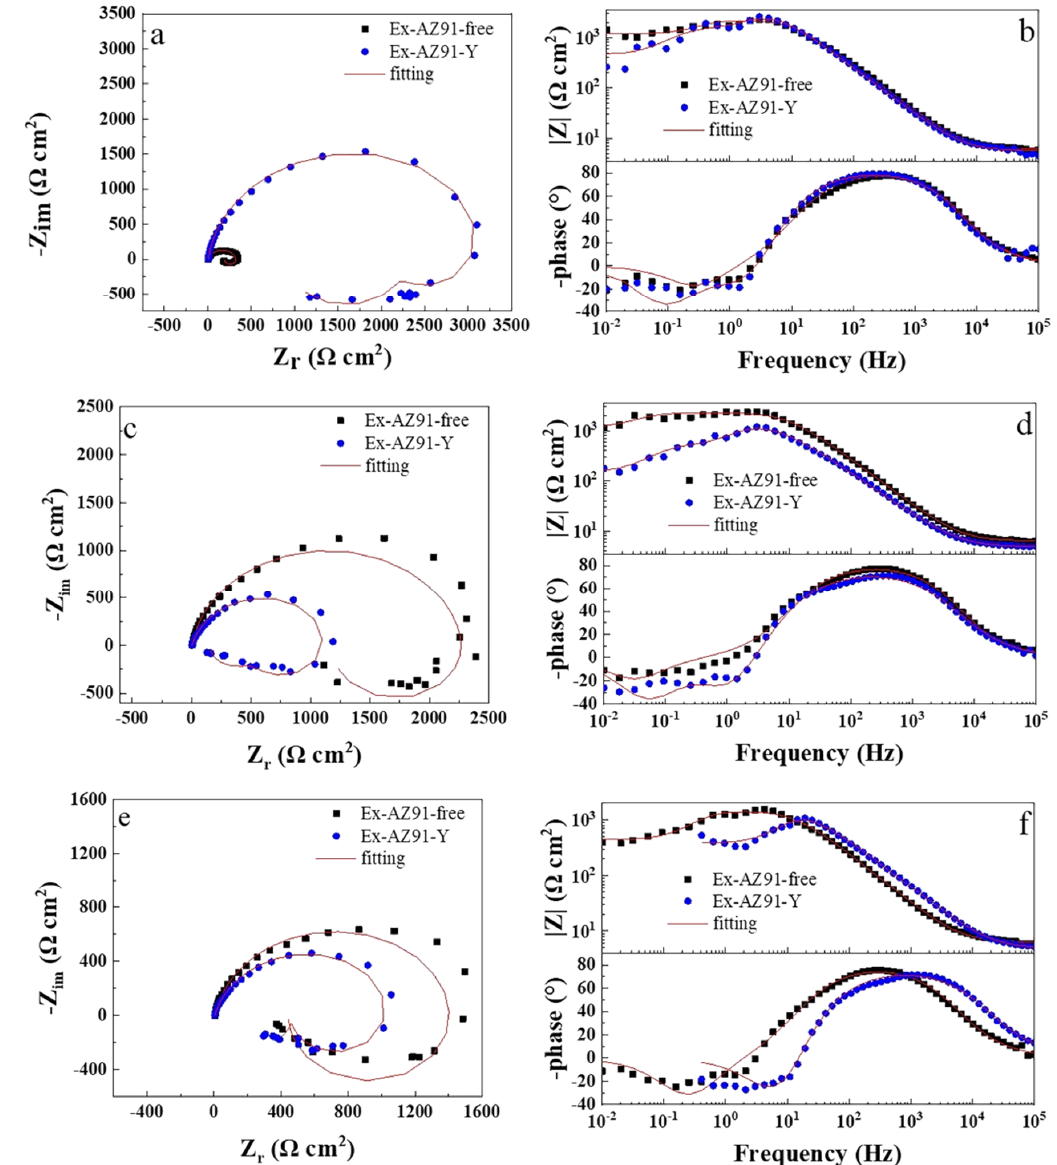
Figure 9. Nyquist and Bode plots of the longitudinal section of Ex-AZ91-free and Ex-AZ91-Y alloy in the different soaking time, ( a , b ) 2 h, ( c , d ) 8 h, and ( e , f ) 12 h. In an equivalent circuit model (Figure 10), the constant phase element (CPE) replaced the perfect capacitors, which represents nonideal capacitive behavior in the surface of the electrodes. R s is the solution resistance, CPE dl is the double layer capacitance, R t is the charge transfer resistance, R L is the resistance of inductance, and L is the inductance, which is due to the rupture of oxide or hydroxide film. In the equivalent circuit model in Figure 10b, L Mg+ is the inductance of the Mg + reaction on the breaking area of partial protective film and R L, Mg+ is the resistance of the Mg + reaction [17,36].